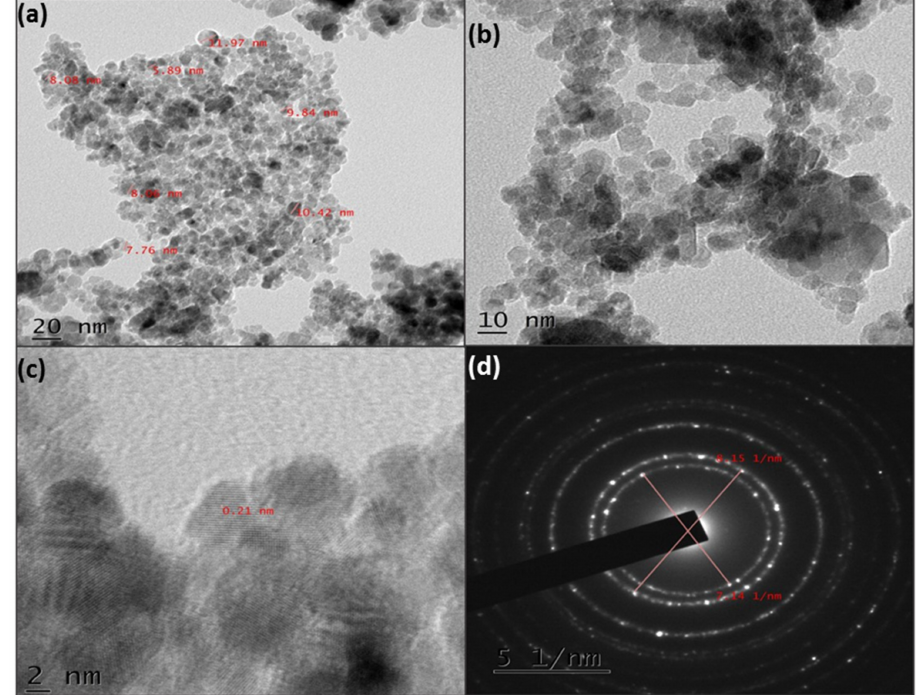
Figure 5. ( a , b ) TEM images, ( c ) HR-TEM image, and ( d ) SAED of as-prepared NiO NPs.